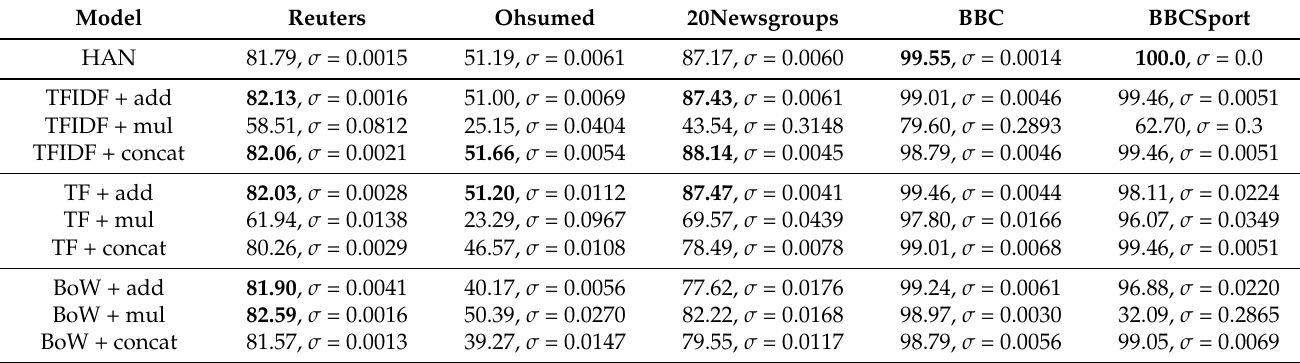
Table 4. Averaged overall classification accuracy (in percent) for HAN and variants of HWAN; cross-validation for Ohsumed, BBC and BBCSport, test-train split for Reuters and 20Newsgroups. Restricting input length at 99-th percentiles of the number of sentences and words. Numbers in bold denotes results better than baseline HAN